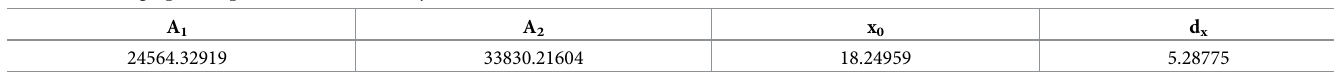
Table 28. Fitting equation parameters of efficiency of